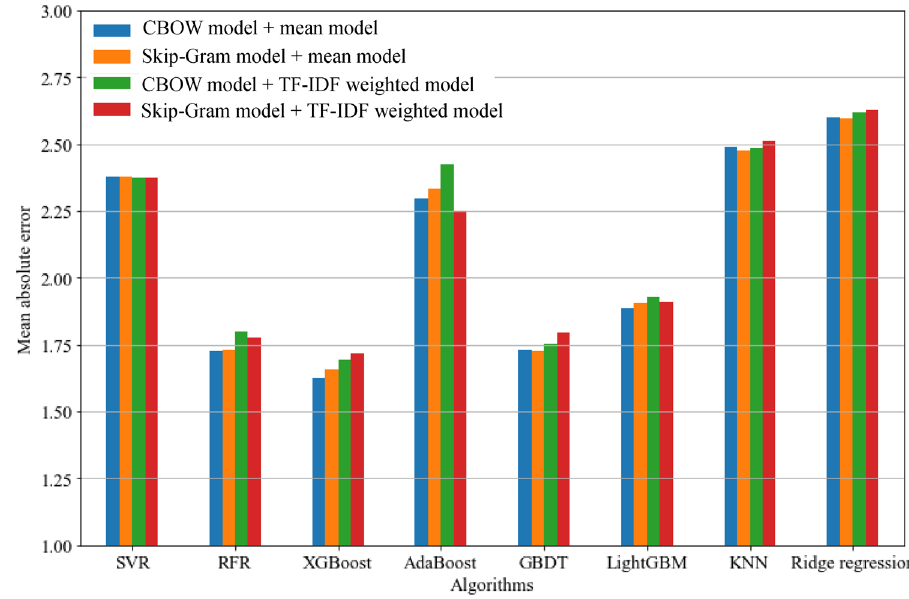
Fig. 16 Histogram of MAE of different text feature processing methods and regression